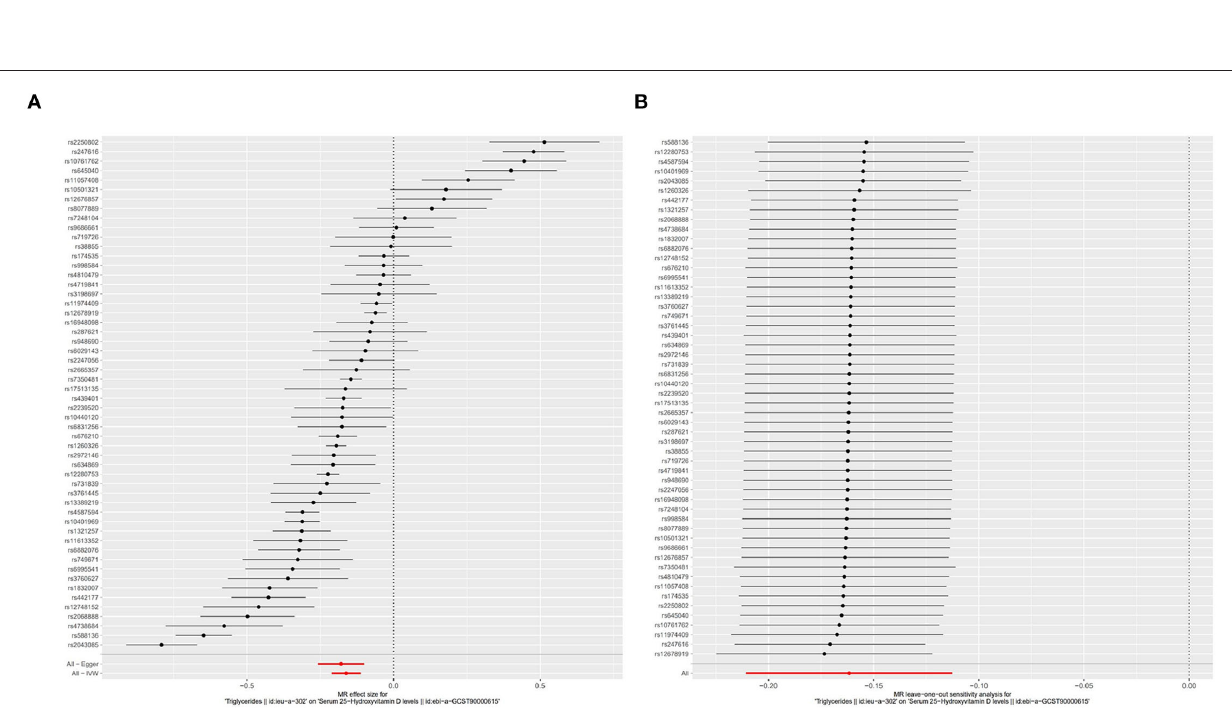
analysis to identify independent SNPs and calculate an adjusted estimate